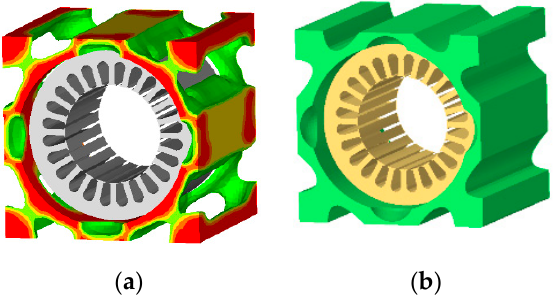
Figure 7. Result of Topology Optimization: Rectangular shape housing design ( a ) Topology opti- mization result of element density ( b ) Redesign model.